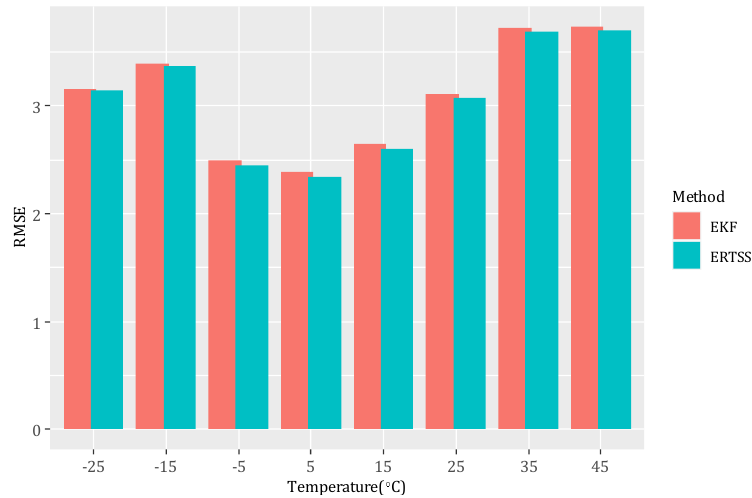
Figure 13. RMSE of the SOC estimation for both ERTSS and